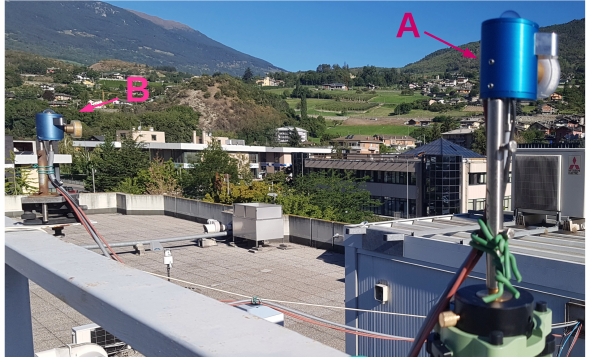
Figure 3. Entrance optics of the array spectroradiometer ( A ) and of the reference Bentham spectrora- diometer ( B ). The two optics, both based on Bentham D7 global diffusers, are